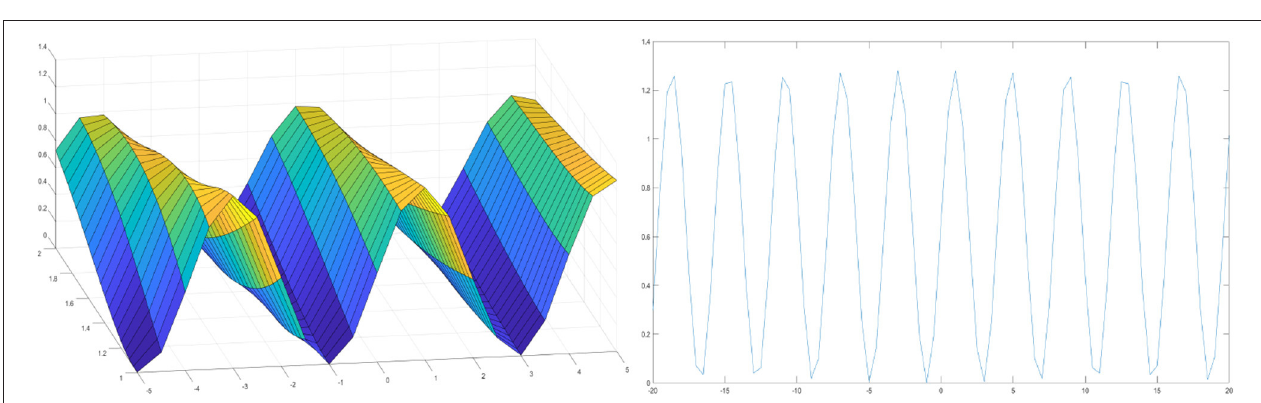
t . 1, α 3, p 1, β 2, γ ( t ) = = = − = =